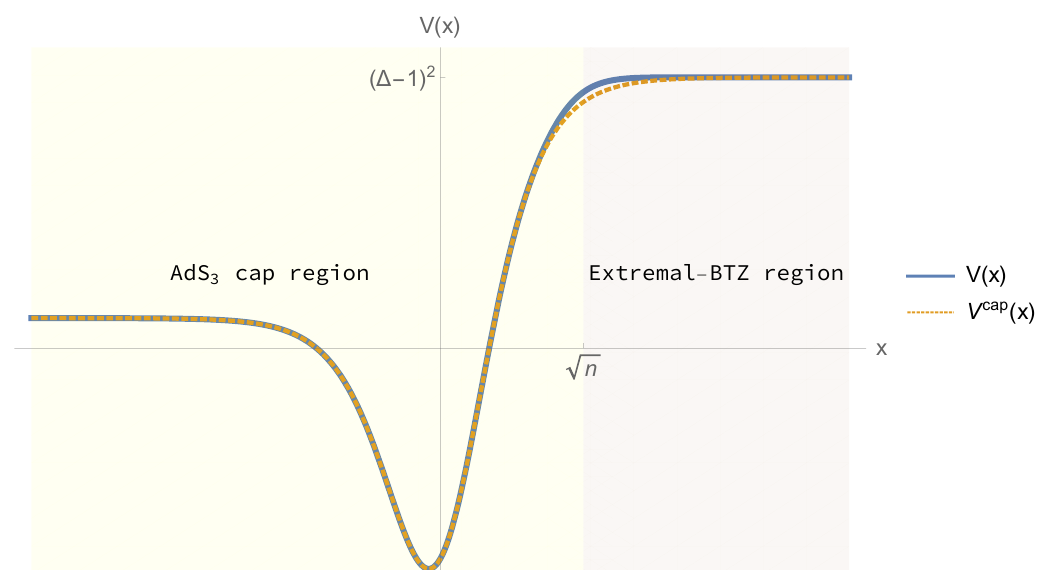
Figure 6: The cap regime: The superstratum potential V ( x ) and the approximated potential V cap ( x ) when | Ω | (cid:174) 2